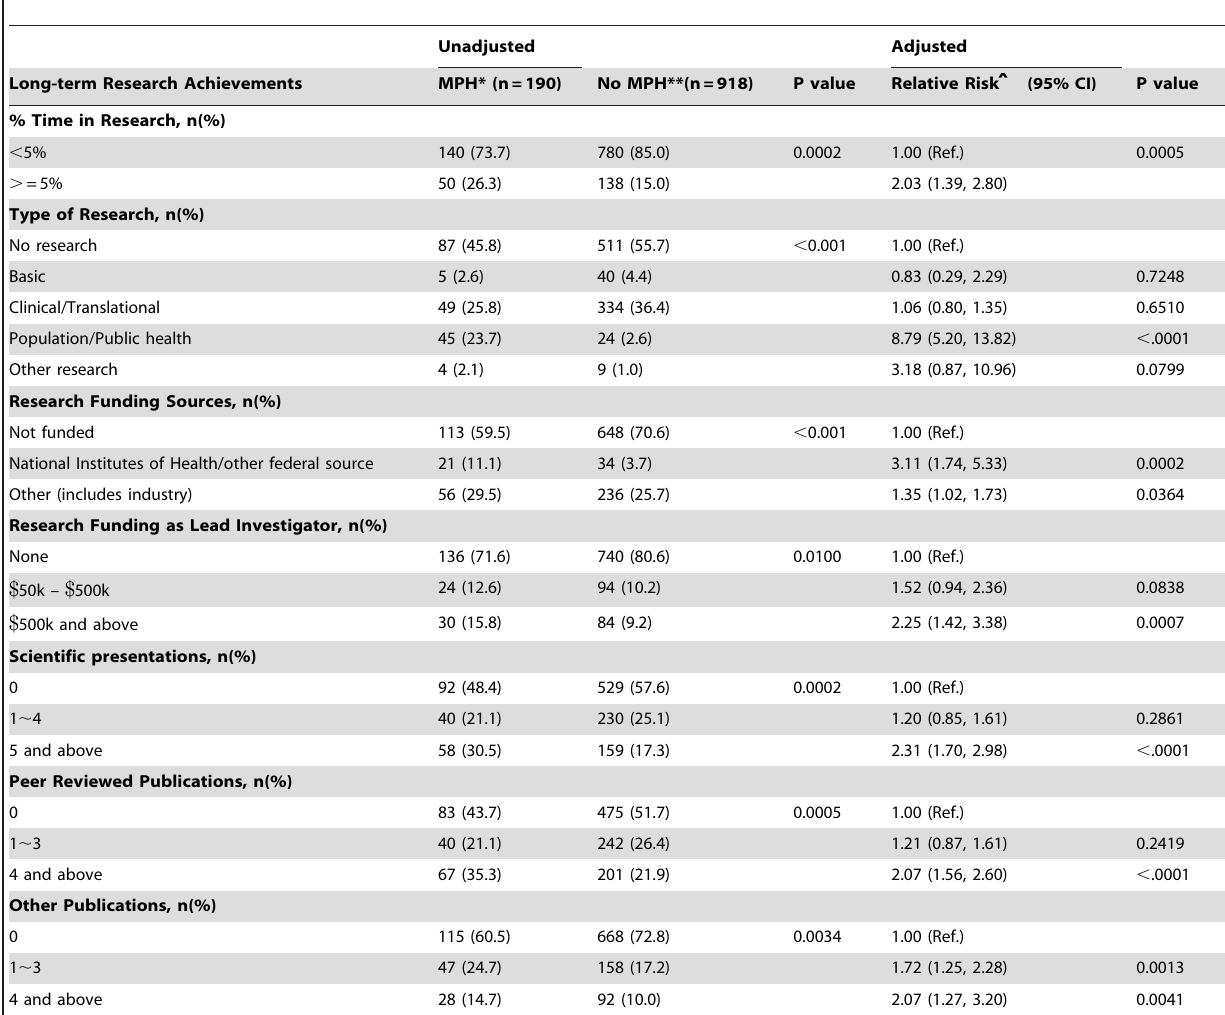
Table 5. Analyses of Long-term Research Achievements Associated with MPH Education Completion among Medical School